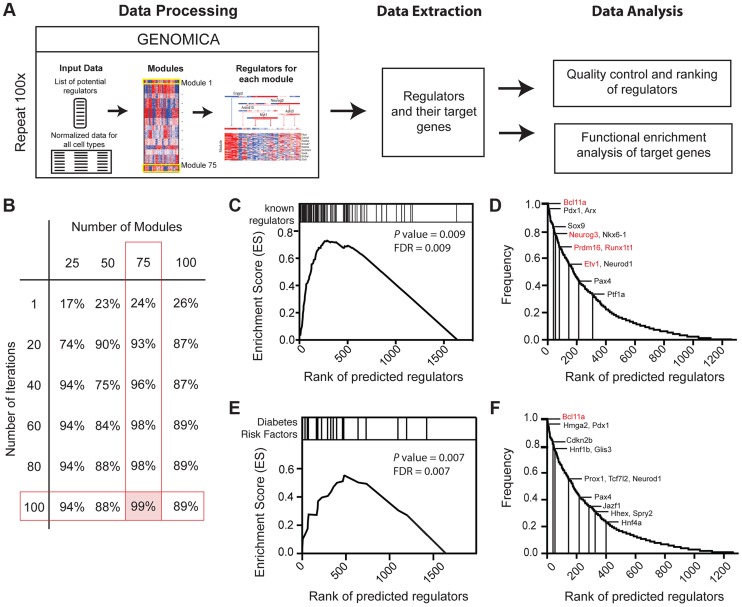
Expression-based identification of pancreatic regulators.(A) Schematic of approach used to identify regulators of pancreas development, their targets, and their predicted biological functions using the module network algorithm of Genomica. To identify regulators two lists are loaded into the program: 1) a list of potential regulators and 2) normalized expression values of samples. Genes with similar expression patterns are grouped (termed a module). Regulators that are most predictive of a specific module expression pattern are learned. Output information includes a list of regulators and their potential targets. Functional enrichment analysis is used to predict the biological function of each regulator (see Methods for details). An example of module-network analysis nominating Neurog3 as a candidate regulator of endocrine development is shown along with its potential targets. (B) Optimal number of modules and iterations were determined by calculating the percentage of known regulators of pancreas development for each module and iteration combination. (C) Gene set enrichment analysis (GSEA) for 100 iterations of 75 modules yielded an enrichment score greater than >0.5 when known regulators were used. Distribution of known regulators based on their rank is displayed on the top panel. (D) Ranking of candidate regulators based on their frequency. Among the most reproducible candidates included known pancreas regulators such as Pdx1 and Neurog3 (red font) and candidate regulators validated in subsequent analysis (red font). (E) GSEA plot for the distribution of diabetes risk factors among list of predicted regulators. (F) Ranking of diabetes risk factors based on their frequency score. Validated GWAS genes include Bcl11a (red). (D and F) A frequency of 1.0 means that the candidate regulator appeared in 100% of the iterations performed.